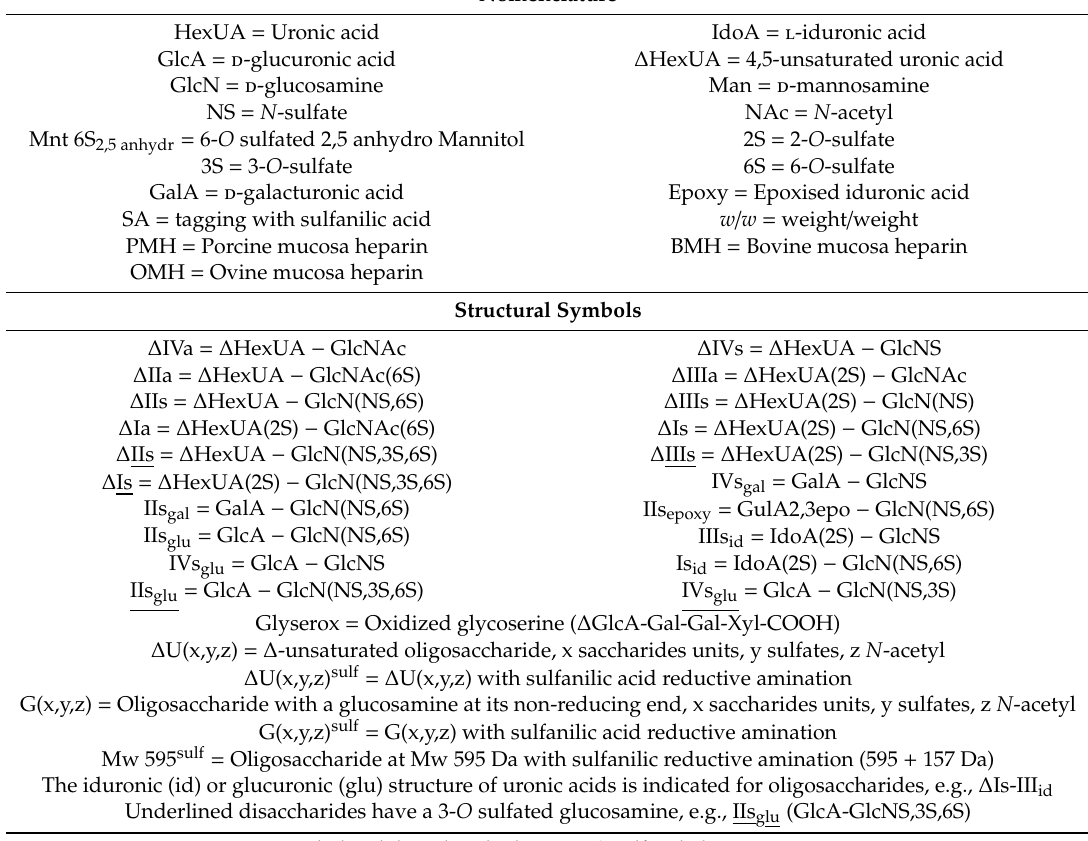
Table 1. Nomenclature and structural